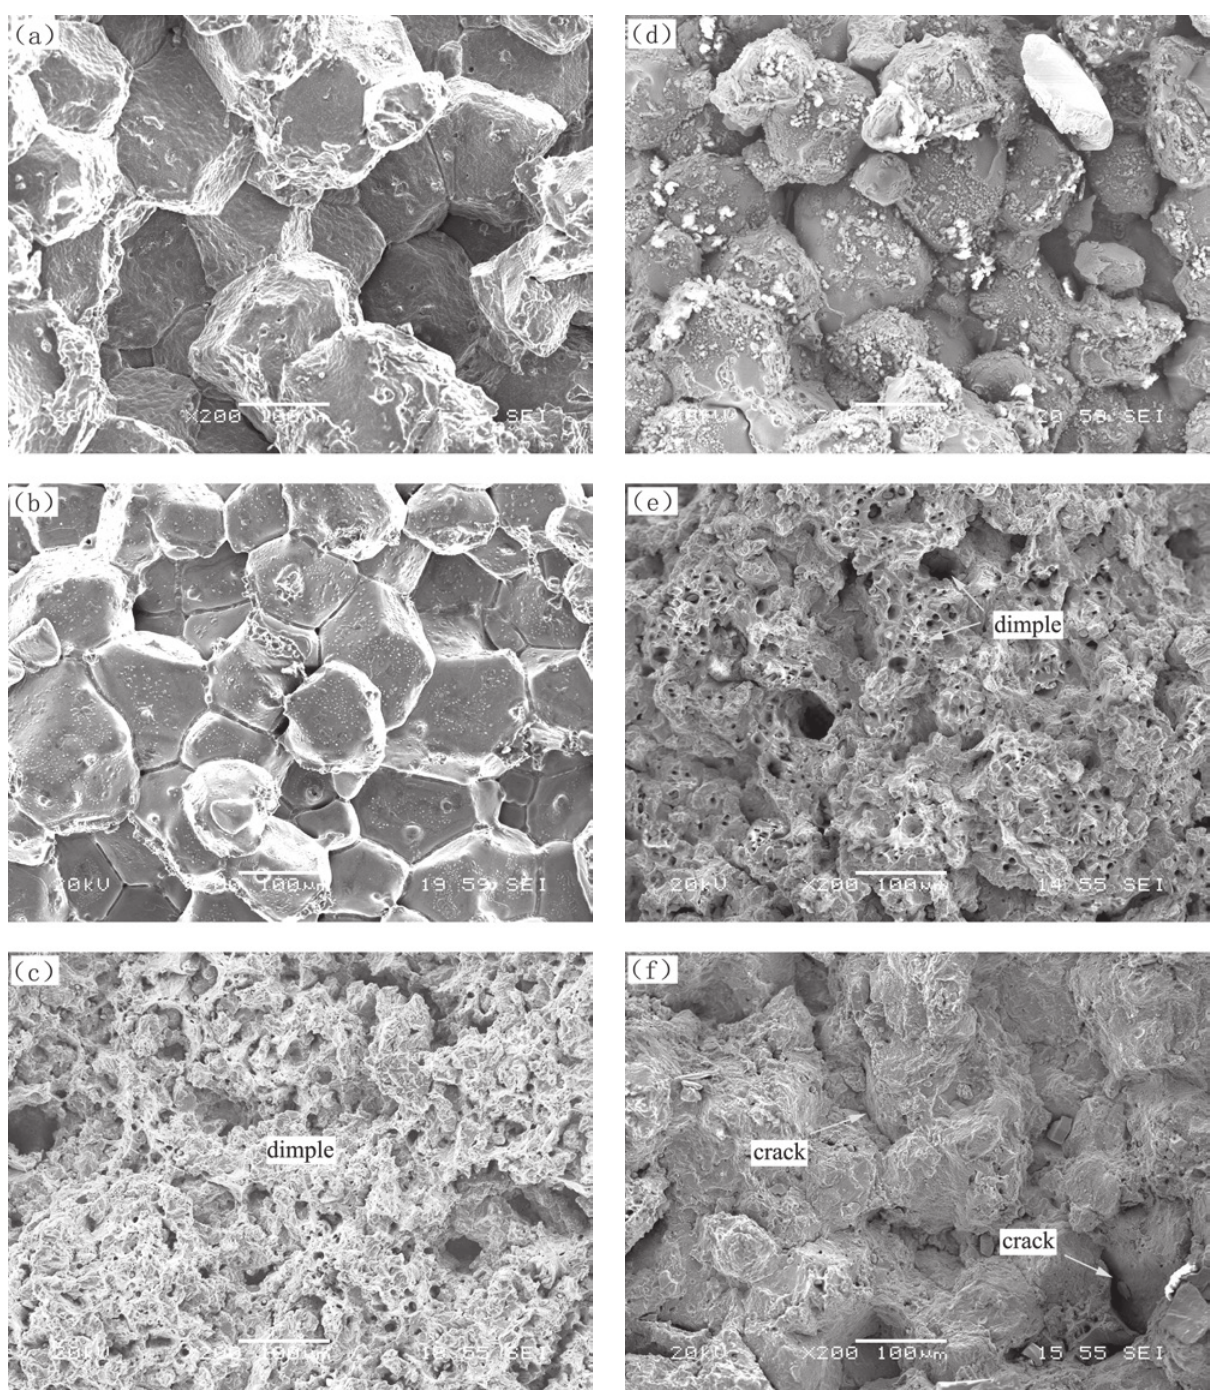
Fig. 3: Fracture morphology of tensile tested samples: (a) steel 1 at 1150 °C; (b) steel 1 at 1000 °C; (c) steel 2 at 1150 °C; (d) steel 2 at 1000 °C; (e) steel 4 at 1150 °C; (f) steel 4 at 1000